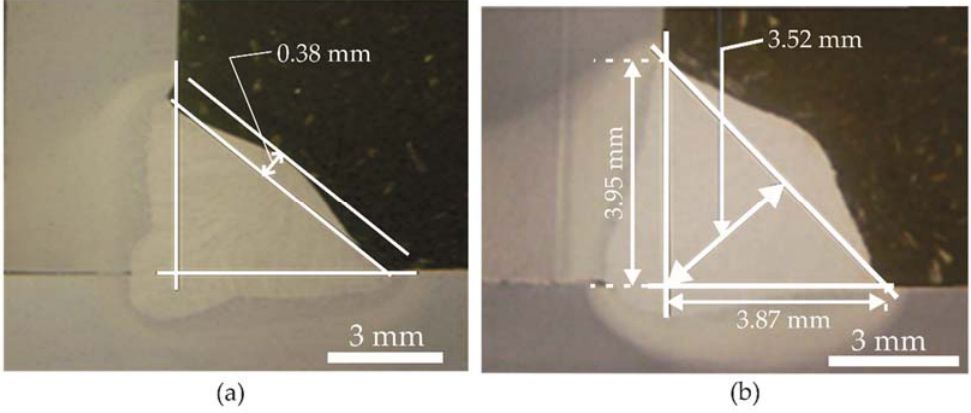
Figure 8. ( a ) Test specimen for convexity validation and ( b ) lowest values found for the theoretical throat and the length of length.